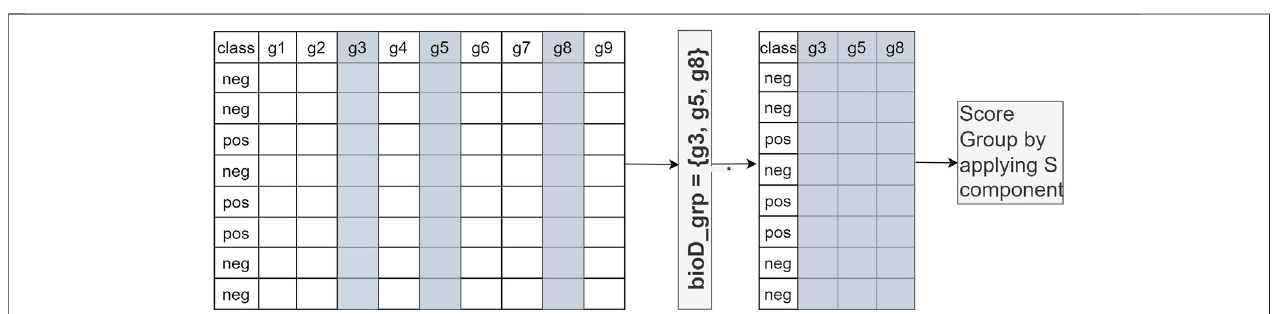
FIGURE 3 | An example of how to create sub_data based on a group of genes and then this sub-data is subject to the scoring component S. g i refers to gene i .